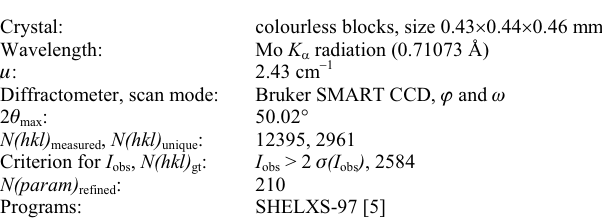
Table 1. Data collection and handling.